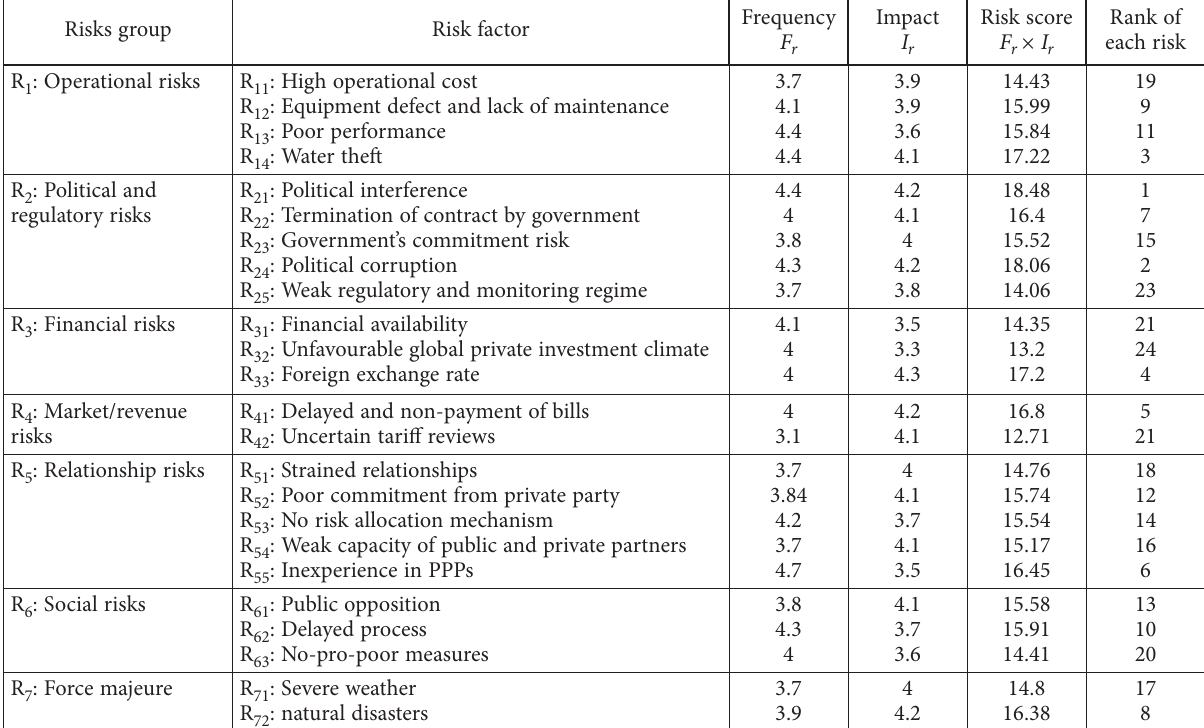
Table 5. Significant risks in water and sewerage PPP projects in